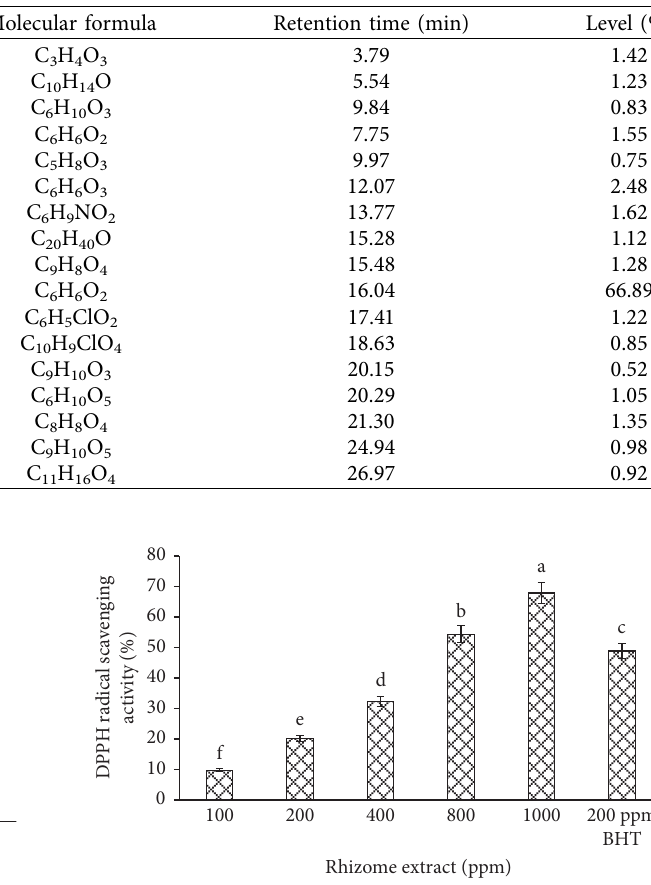
Figure 2: Total phenolic compounds at different concentrations of the methanolic extract of C. dactylon rhizomes (different letters indicate statistically significant differences between groups as de- termined by the Duncan test ( p < 0 . 05)).